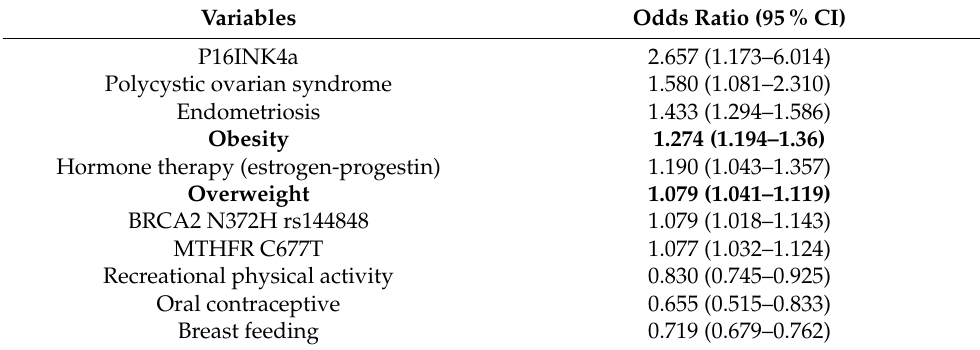
Table 1. Factors influencing the risk of developing EOC (OR + 95% CI)